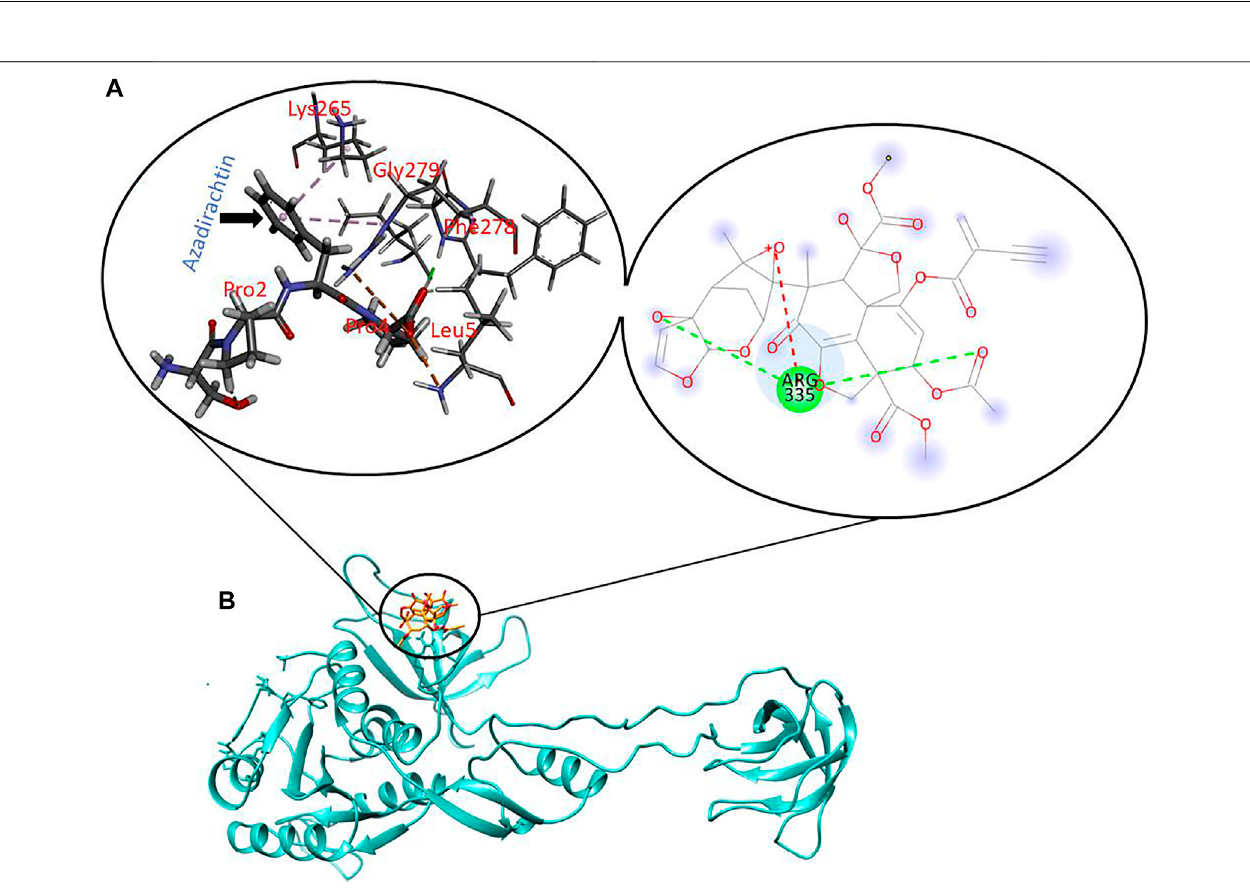
Frontiers in Pharmacology |